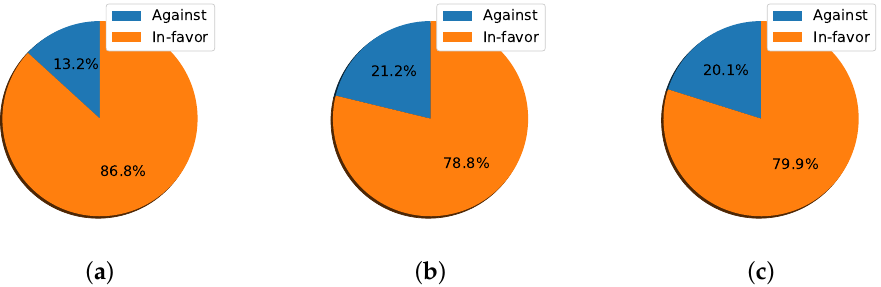
Figure 7. The percentage of In-favor and Against tweets of the three events occurring in the first semester of the 2020 academic year. ( a ) A1. ( b ) A2. ( c ) A3.